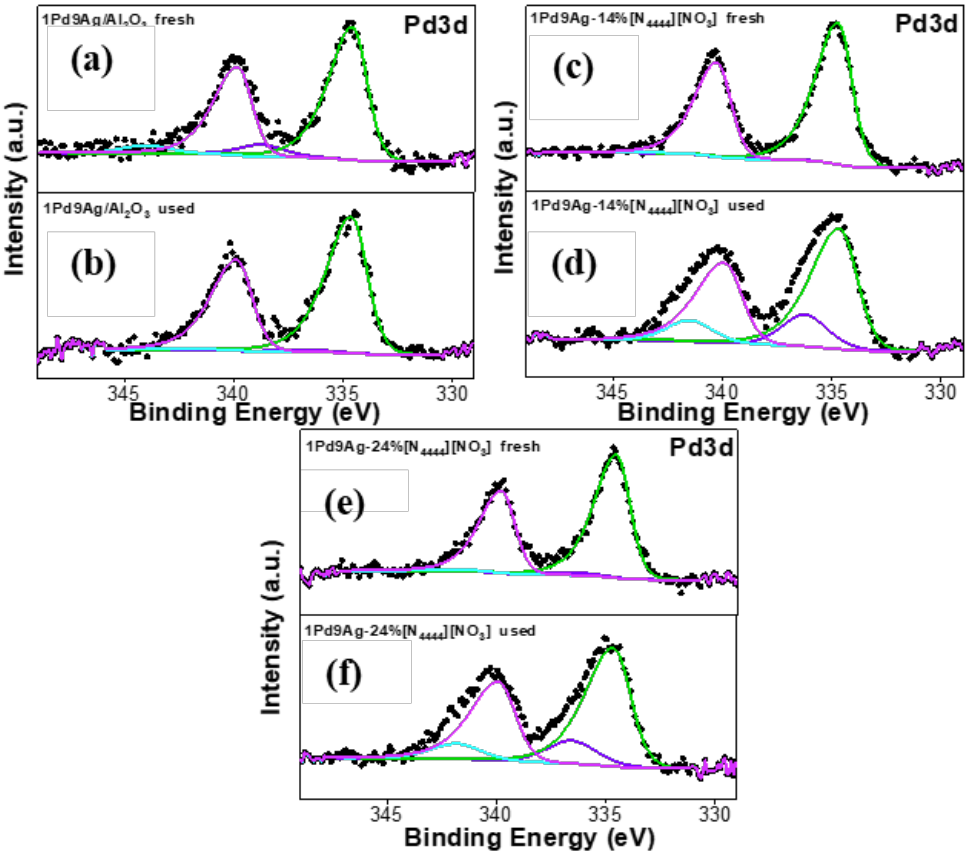
Figure 9. Pd 3d XP spectra for the fresh and used catalysts: fresh 1Pd9Ag/Al 2 O 3 ( a ), used 1Pd9Ag/Al 2 O 3 ( b ), fresh 1Pd9Ag-14%[N 4444 ][NO 3 ] ( c ), used 1Pd9Ag-14%[N 4444 ][NO 3 ] ( d ), fresh 1Pd9Ag-24%[N 4444 ][NO 3 ] ( e ) and used 1Pd9Ag-24%[N 4444 ][NO 3 ] ( f ). Solid black curves represent the raw data. Fitted individual components are also shown by solid-coloured curves.